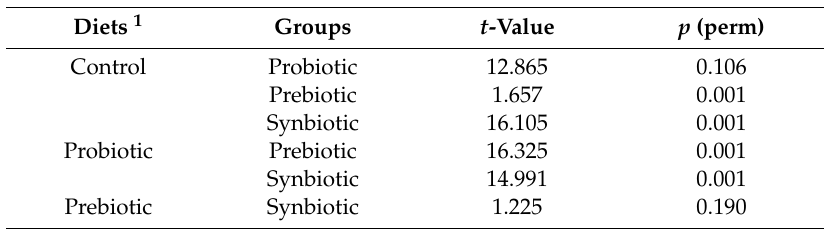
Table1. Statisticaldi ff erencesbetweenthedietsandthemainOTUscontributingtothececaltaxonomical di ff erences in the four metagenomes. 1 Control—no additive supplementation; Probiotic—2 g / kg of